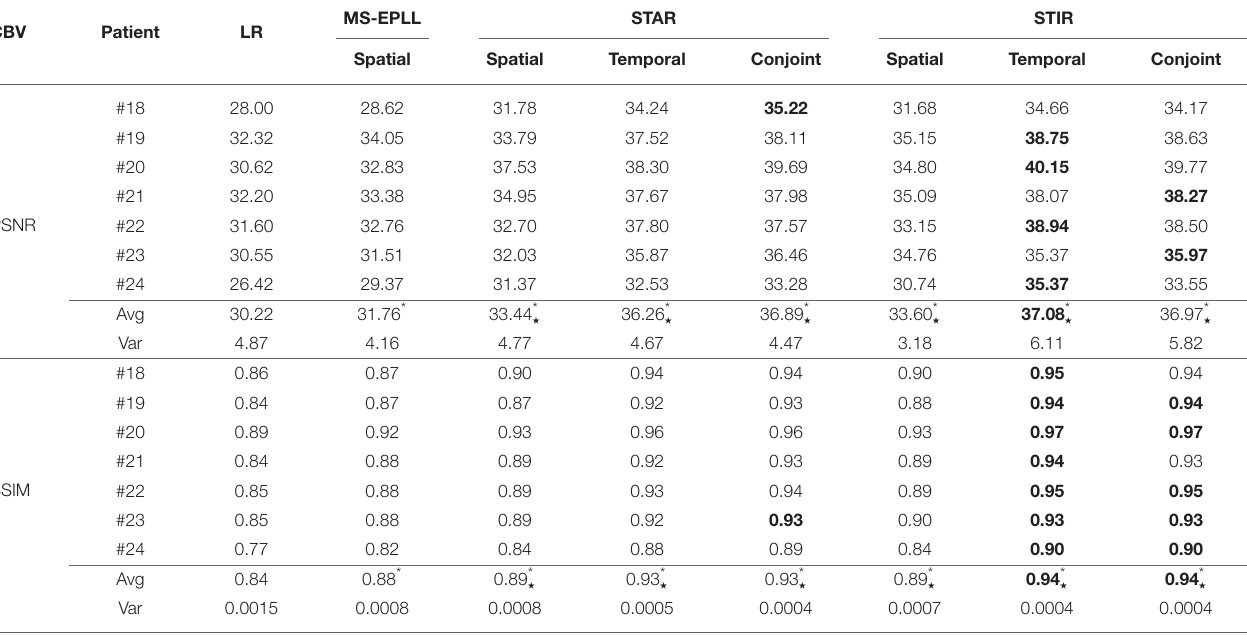
TABLE 5 | PSNR and SSIM value comparison of seven patients’ CBV maps calculated at scale S 2 with tube current 40 mAs.